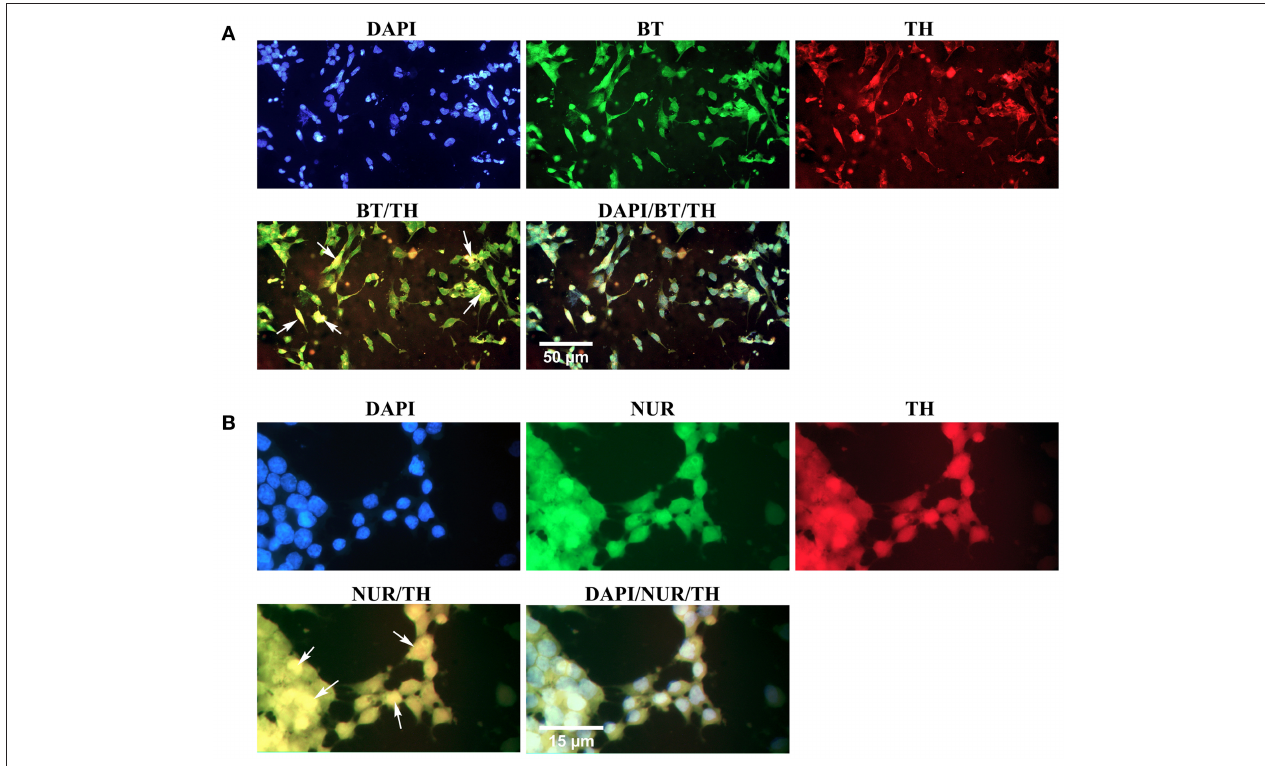
FIGURE 8 | Simultaneous expression of dopaminergic specific proteins in neuron-like cells in the second week of the differentiation protocol. (A) Double immunofluorescence staining with antibodies against β -III tubulin (BT, green) and tyrosine hydroxylase (TH, red) confirmed co-expression of a pan-neuronal marker and a dopaminergic specific protein in the differentiated cells (arrows, yellow). (B) Double immunofluorescence staining with antibodies against Nurr1 (NUR, green) and TH confirmed co-expression of these dopaminergic specific proteins in the differentiated cells (arrows, yellow). DAPI was applied to counterstain the nuclei. BT, β -III tubulin; TH, tyrosine hydroxylase; NUR,